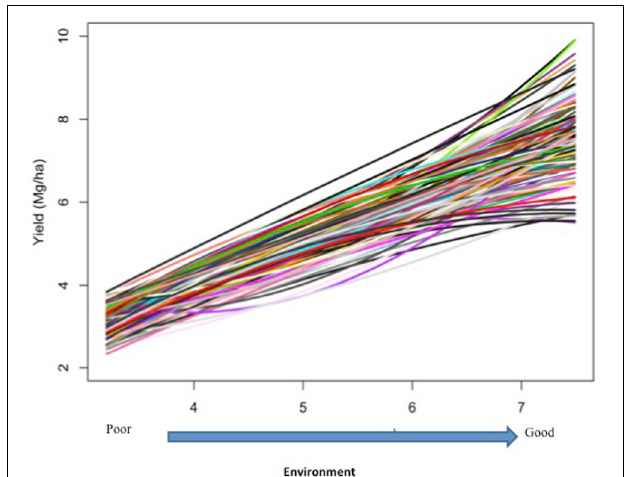
FIGURE 2 | Responses of 150 doubled-haploid lines of barley from a cross between two malting barley cultivars (Steptoe × Morex) for the North American Barley Genome Mapping Project (NABGMP). The range of the environmental index values runs from low (poor environment) to high (good